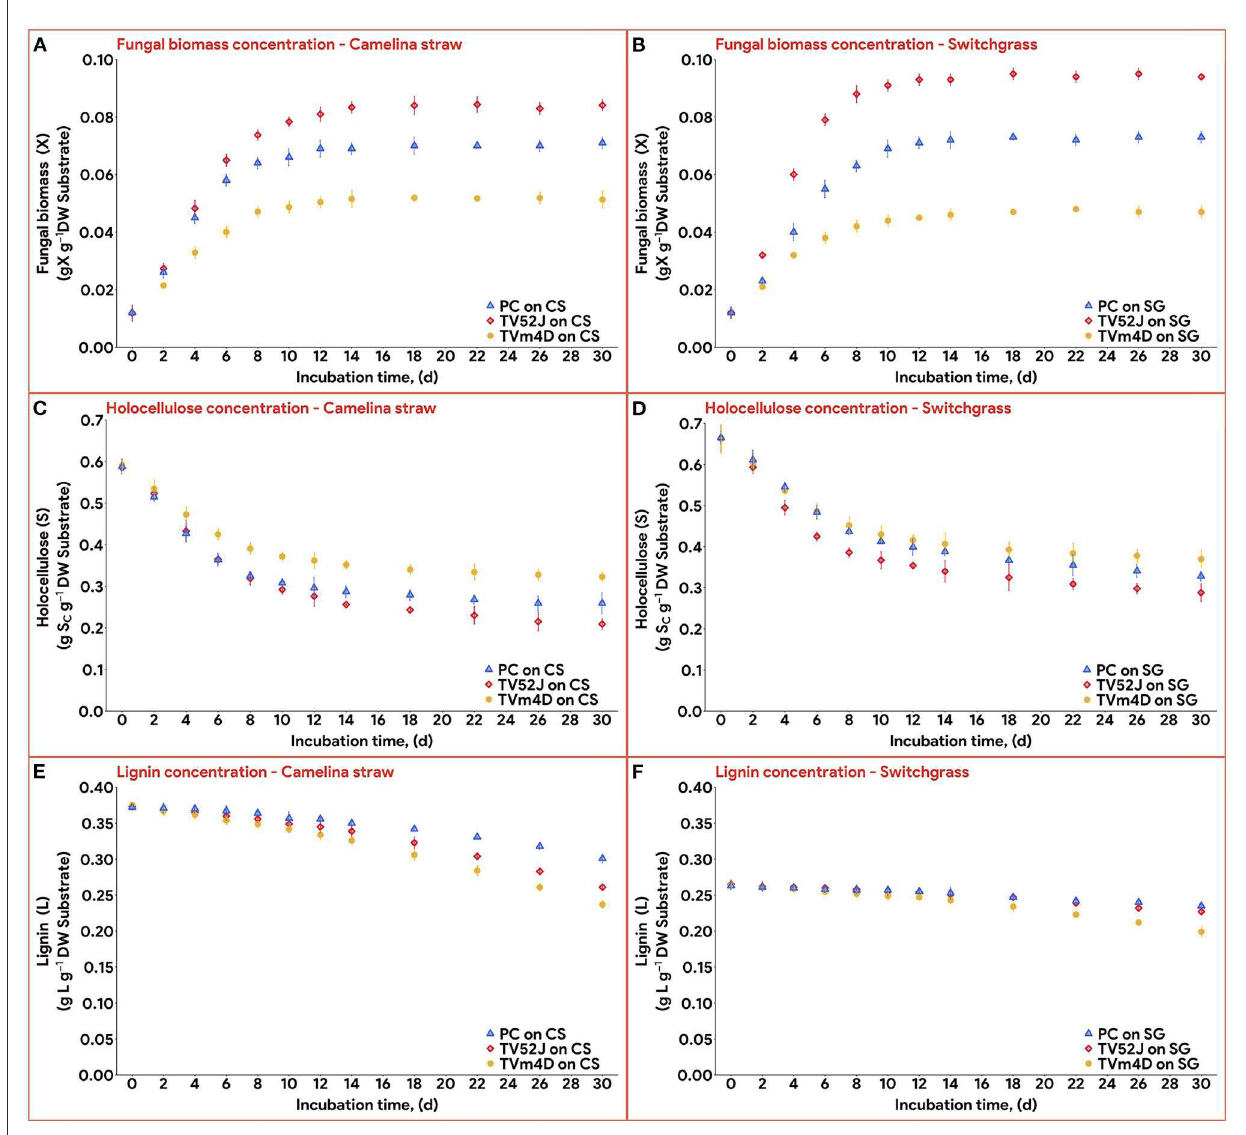
FIGURE3 Concentration of fungal biomass (X), holocellulose substrate (S), and lignin content (L) during 30 d of microbial pretreatment: (A) : X profiles of CS, (B) : X profiles of SG, (C) : S profiles of CS, (D) : S profiles of SG, (E) : L profiles of CS, (F) : L profiles of SG. PC, P. chrysosporium ; TV52J, T. versicolor 52J; TVm4D, T. versicolor m4D; CS, camelina straw; SG,